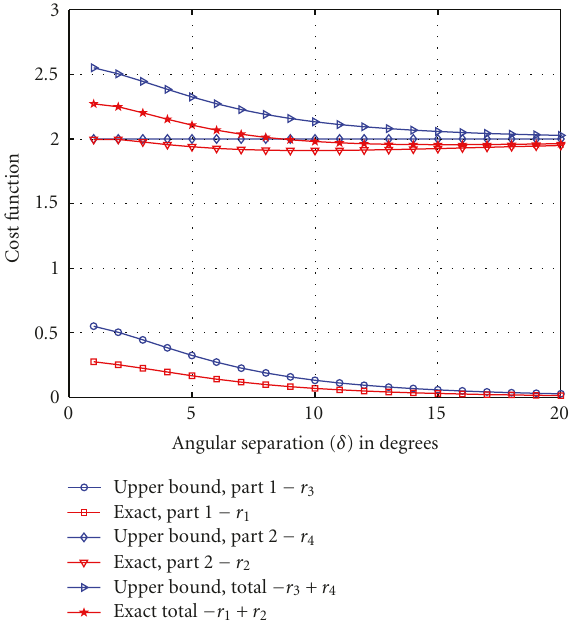
Figure 6: Exact cost function and its upper bound in (36) versus δ for the user i = 1 ( w i is obtained from (32), and Gaussian AoA model is used, r 1 = (1 /γ 0 ) s con , r 2 = (1 /N ) tβ , r 3 = ( and r 4 = t ( K − 1)).